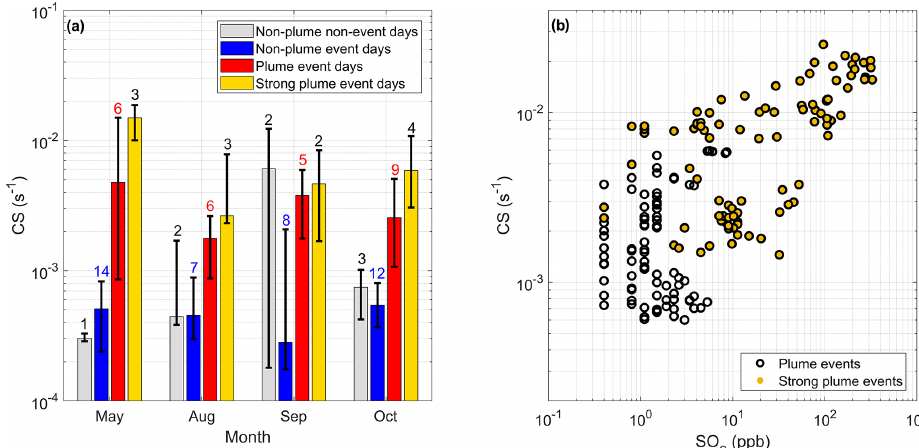
Figure 4. (a) Monthly medians and percentiles of the CS measured prior to NPF hours (i.e. 05:00–07:00LT). Note that strong plume days are included in the statistics reported for plume days and are also highlighted separately. See Fig. 3 for an explanation of symbols. Numbers on the plot indicate, for plume and non-plume conditions, event and non-event days, the total number of days included in the statistics. (b) Link between the CS measured prior to NPF hours and SO 2 mixing ratios on plume days. Strong plume days are highlighted with specific markers.